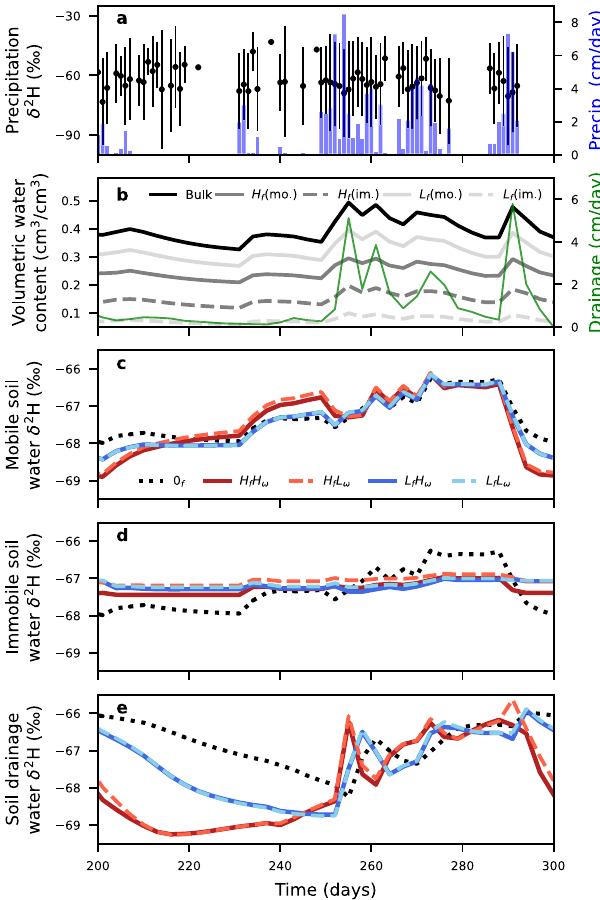
Fig. 1 | Simulated precipitation, soil pore space waters, and drainage isotope ratios. a Averaged downscaled fl ux-weighted precipitation δ 2 H isotope value with errorbarsdenoting ±1 standarddeviationfrom the ten input simulations as wellas thedailyinputprecipitationamountasbluebars. b Averagedtimeseriesoftheten simulatedvolumetricwatercontentsofasingleporositysoil(Bulk,solidblackline), the mobile and immobile volumetric water contents for a soil with high immobile fractions ( H f (mo.) and H f (im.) respectively, dark gray), and the mobile and immo- bile volumetric water contents for a soil with low immobile fractions ( L f (mo.) and L f (im.)respectively,lightgray),aswellasthedrainagefromthecolumn(thingreen line). δ 2 H isotope ratios of the c mobile soil water domain, d immobile soil water domain, and e column drainage for the soils simulated with a single pore domain model (0 f , black), high immobile fraction with high and low transfer rates ( H f H ω , red; H f L ω , orange) and low immobile fractions with high and low transfer rates ( L f H ω ,cyan; L f L ω ,blue).Theinputprecipitationtimeserieswasrepeatedthreetimes inseries,withthe fi nal100days(days200 – 300)displayed.Note:linestylesarethe same for c – e and the line for L f H ω is behind L f L ω in d and e